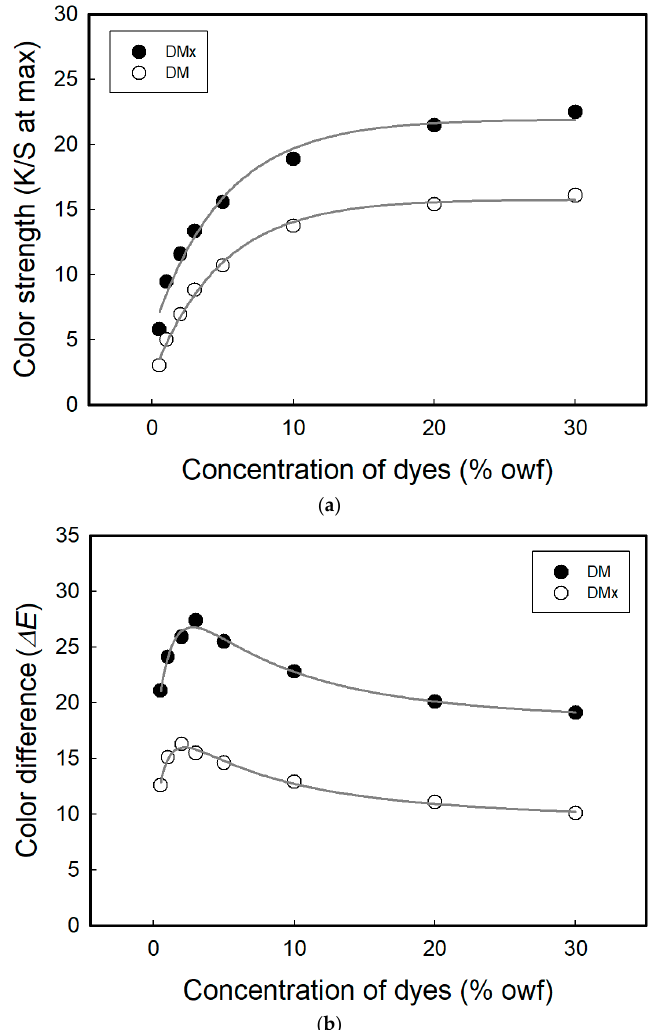
Figure 3. Color strengths at λ max ( a ) and color differences ( Δ E ) in cellulosic fabrics dyed with DMx and DM before and after exposure to DMAc ( b ).